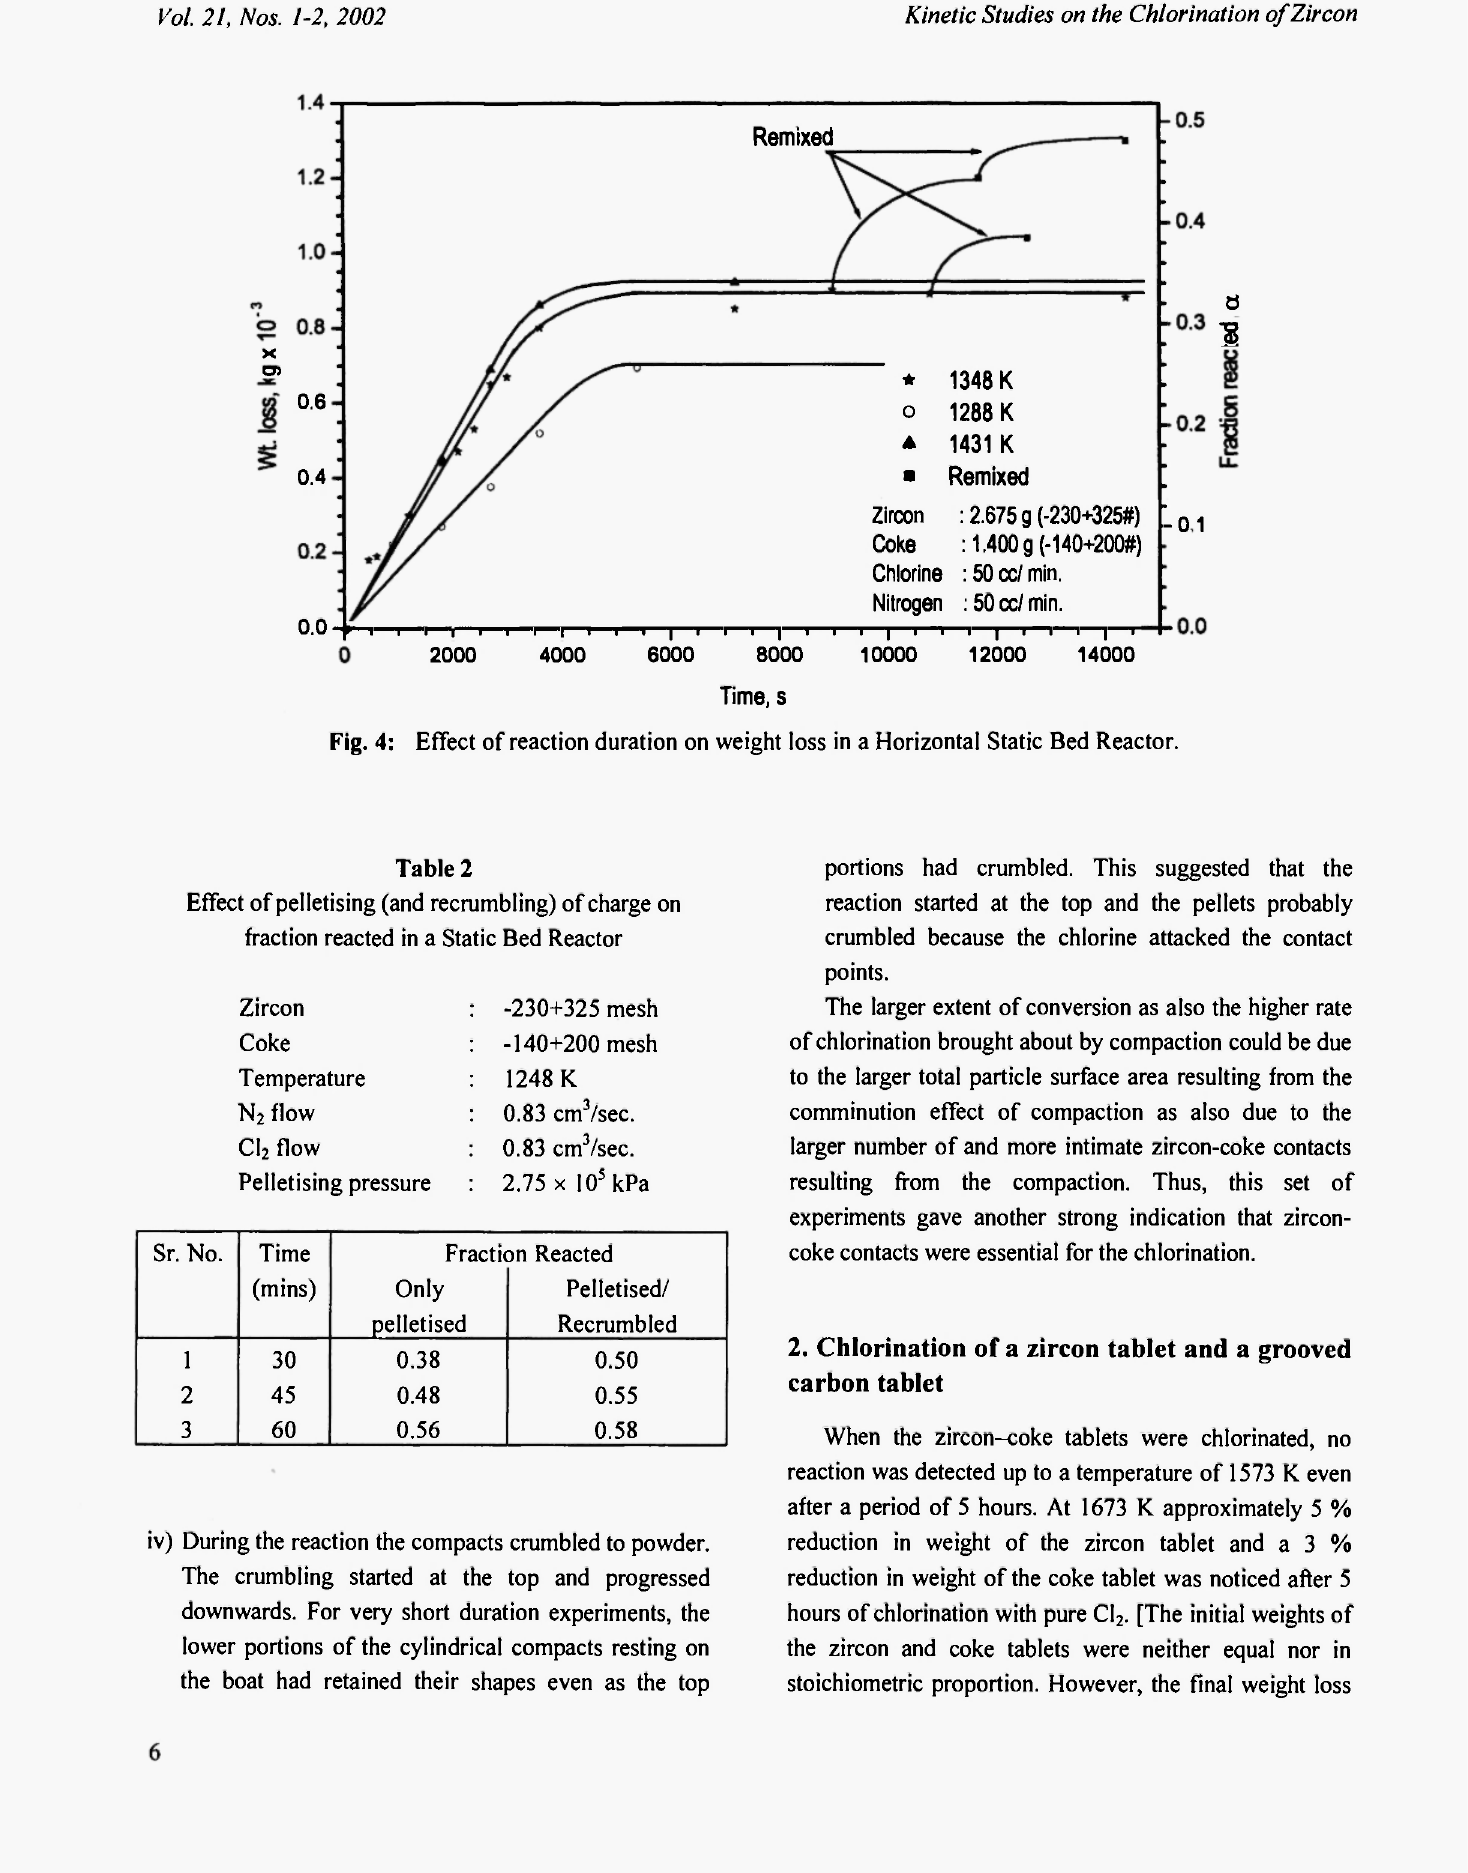
Fig. 4: Effect of reaction duration on weight loss in a Horizontal Static Bed Reactor.